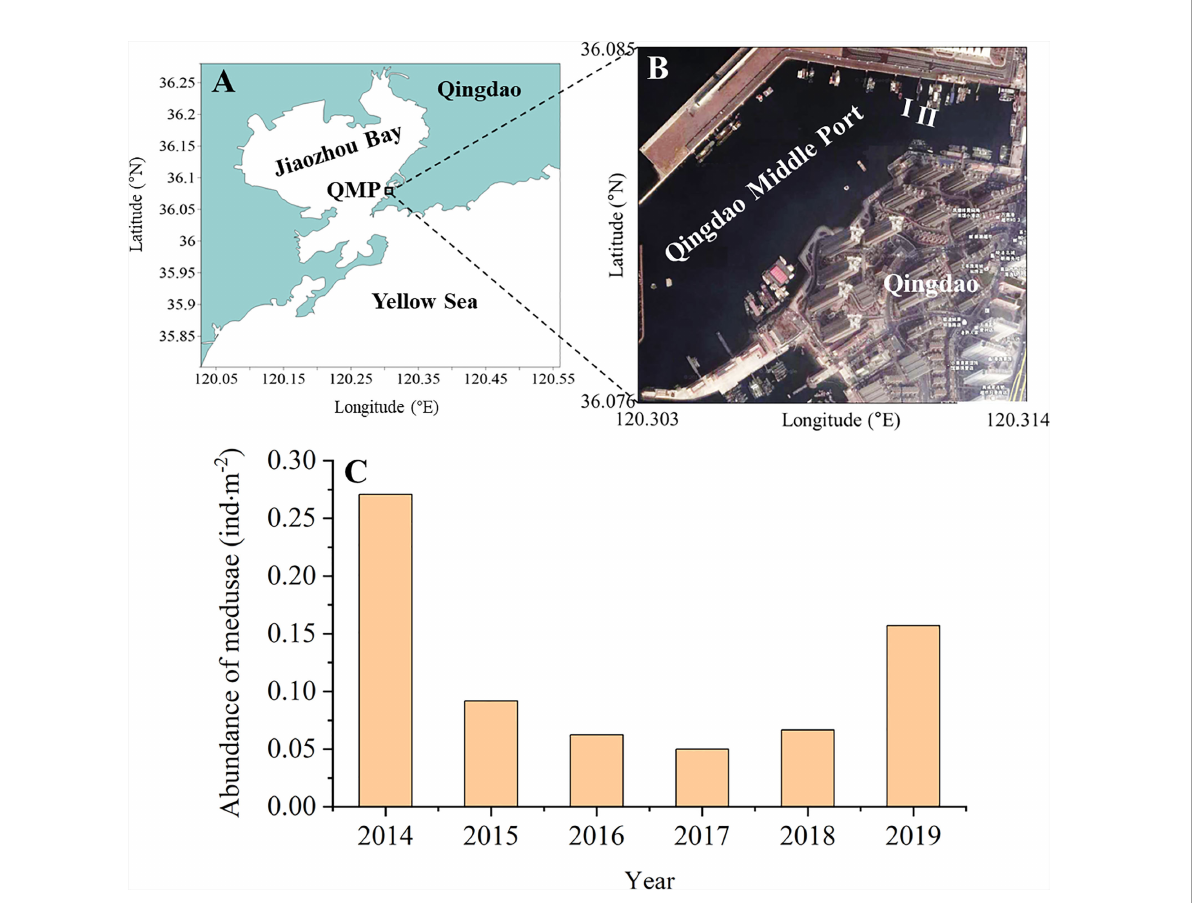
FIGURE 3 Control of Aurelia coerulea blooms in the Qingdao Middle Port, China (A, B) and changes in the abundance of medusae near the seawater surface in June from 2014 to 2019 (C) . Because trawling was banned in the Qingdao Middle Port, the abundance of A. coerulea medusae was monitored through on-deck sighting surveys on the fl oating docks in the middle of June (the blooming period of medusae) as per the methods described in previous reports (Uye, 2014; Yoon et al., 2014). The number of medusae on both sides of docks was roughly counted by the naked eye from 9:00 to 15:00 in a day. The sighting width of the sea surface was estimated as 4m by a trigonometric function. The abundance of A. coerulea medusae was calculated from the total number of medusae observed on docks divided by the total sighting area of the sea surface. QMP: Qingdao Middle